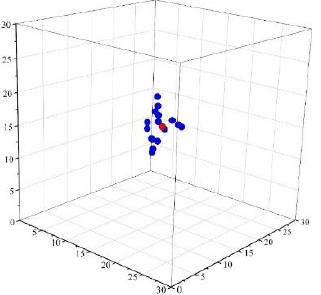
Figure 5. Wolves moving toward the direction of the best particle.